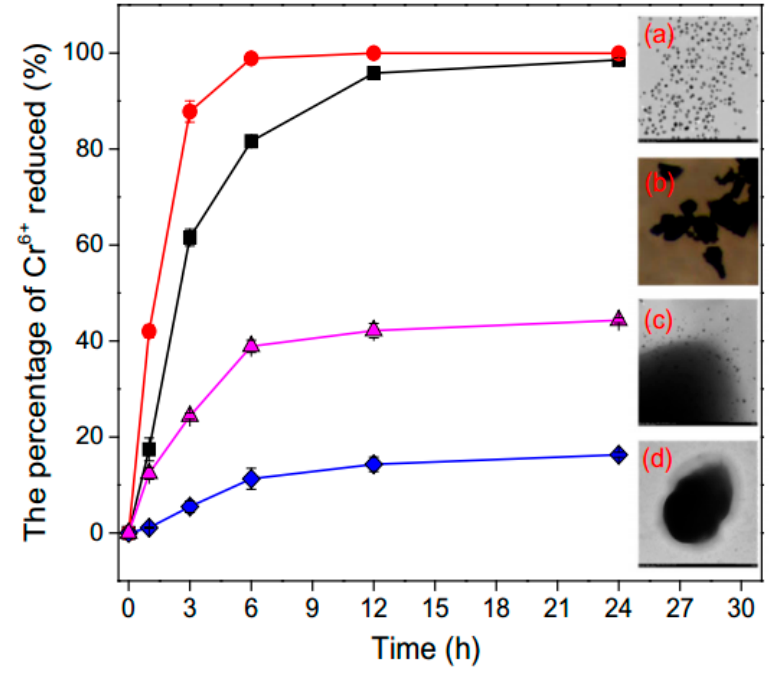
Figure 8. Reduction of 0.5 mM Cr 6+ by ● , sonicated bio-Pd 0 -NPs ( a ); ■ , chem-Pd 0 ( b ); ▲ , bio-Pd 0 -NPs ( c ); and ◆ , E. faecalis cells ( d ) (reprint from [50] with permission from Elsevier. Copyright 2016).